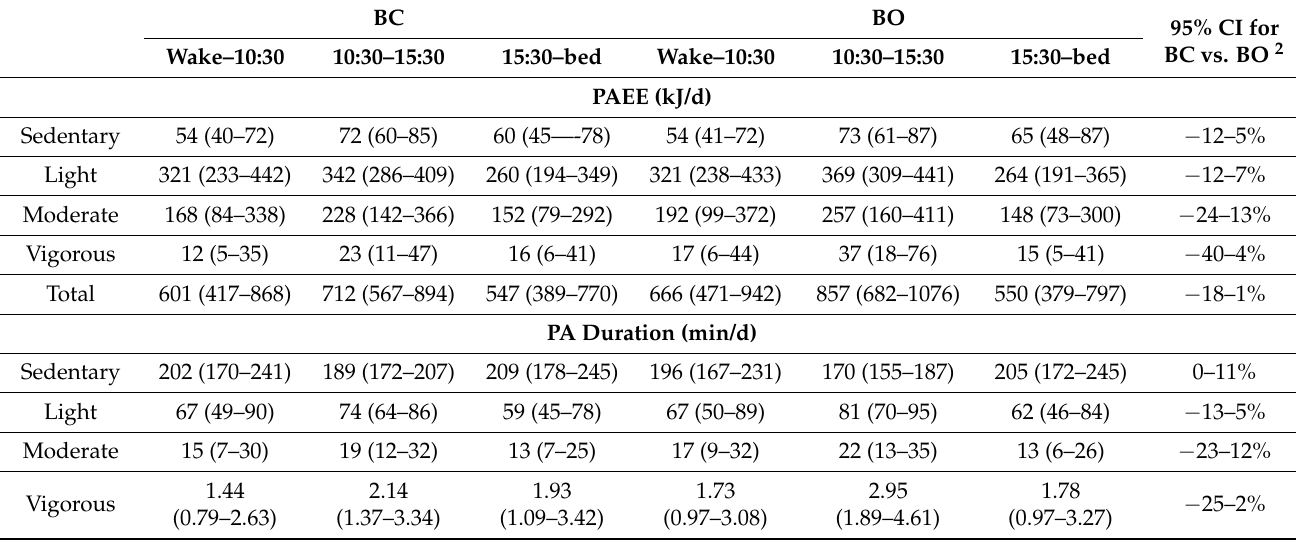
1. Based on natural log-transformed data with values presented as a geometric mean (95% confidence interval (CI)) adjusted for minutes of useable data, n = 15. 2. A total of 95% CI for the percentage difference of the geometric means between the experimental conditions using a condition by time-of-day linear mixed model adjusted for minutes of useable data and condition order. BC was the consumption of a standardised breakfast with an energy content equivalent to 25% of individual resting metabolic rate before 09:00 for seven